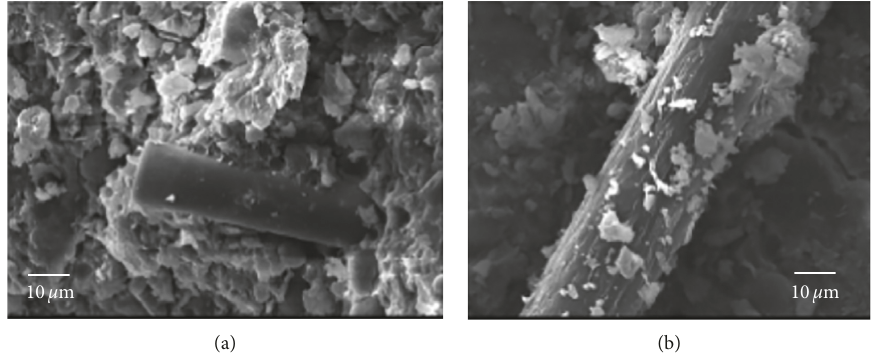
Figure 7: The micromorphology of the (a) BF and (b) PPF fibers in concrete